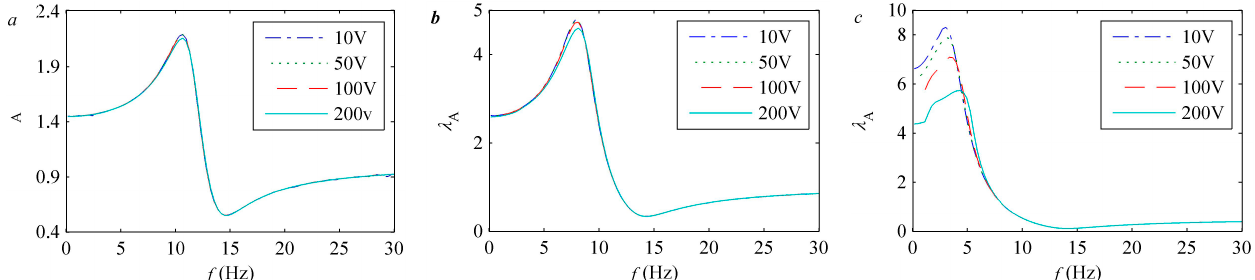
Figure 7. The simulated results for a stiffness of 10 kN/m, applied voltage of 10 V (dash-dot), 50 V (dot), 100 V (dashed), 200 V (solid), and pretension of ( a ) 0.4 mm, ( b ) 0.8 mm and ( c ) 1.2 mm over a range of